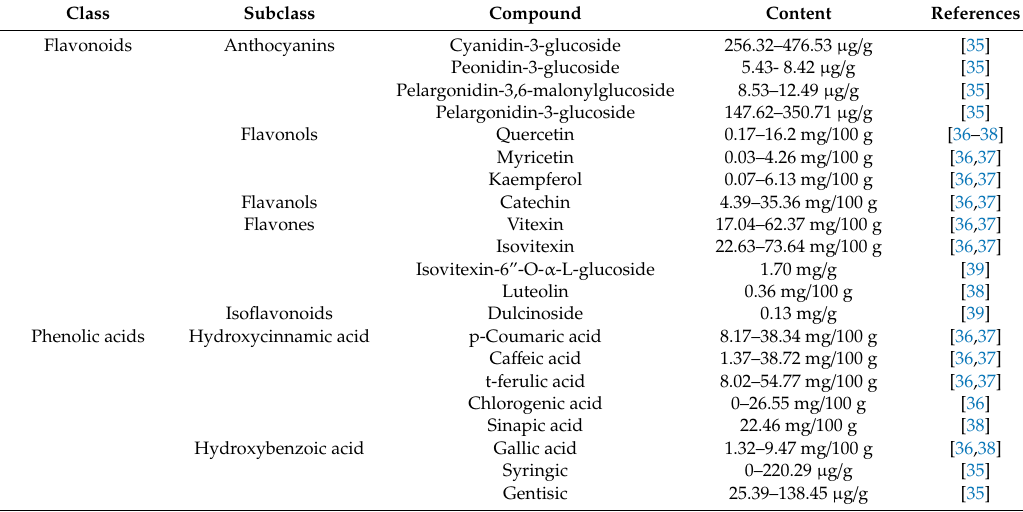
Figure 1. Chemical structures of the main polyphenol constituents in the mung bean. Table 1. Polyphenol composition and relative content in the mung bean (fresh weight).